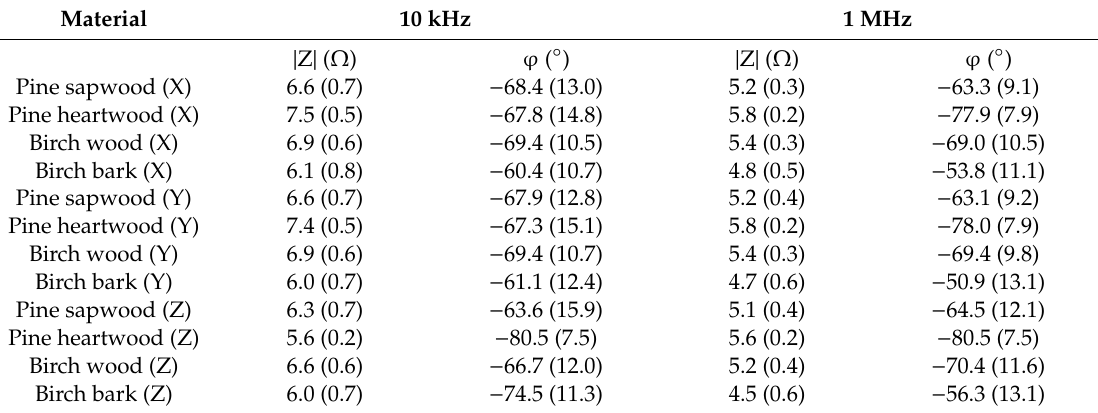
Table 1. Impedance and phase average and standard deviation values at 10 kHz and 1 MHz in